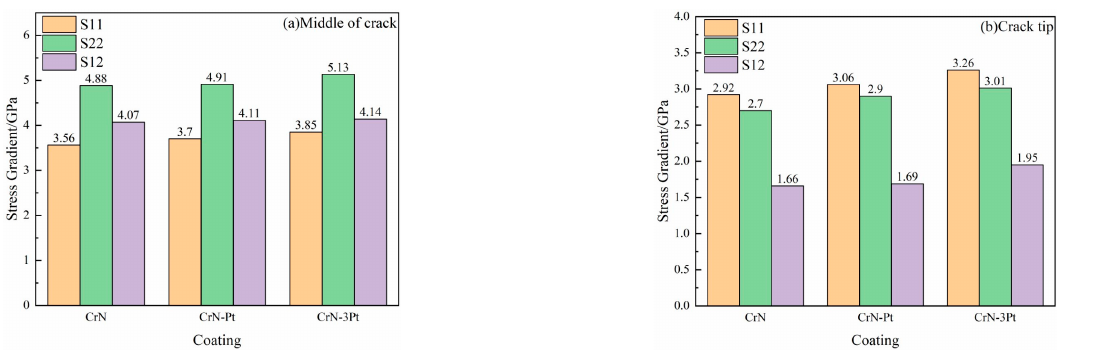
Figure 12. Anisotropic stress distribution at the crack tip of the three coating when the crack prop- agates to the bonding surface of the film base. ( a ) CrN; ( b ) CrN-Pt; ( c ) CrN-3Pt.